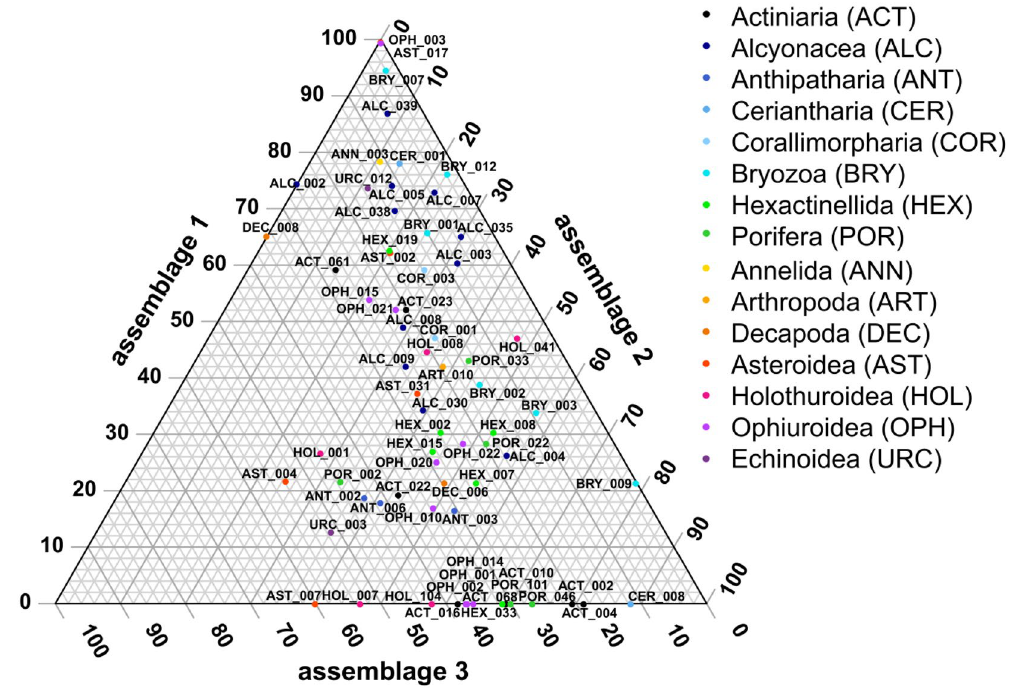
Figure 2. Ternary plot of the percentage occurrences per assemblage of the 68 megafauna morphotypes occurring in more than 10 images (Fig. 1). Only morphotype codes are given, for the complete names see Supplementary Table